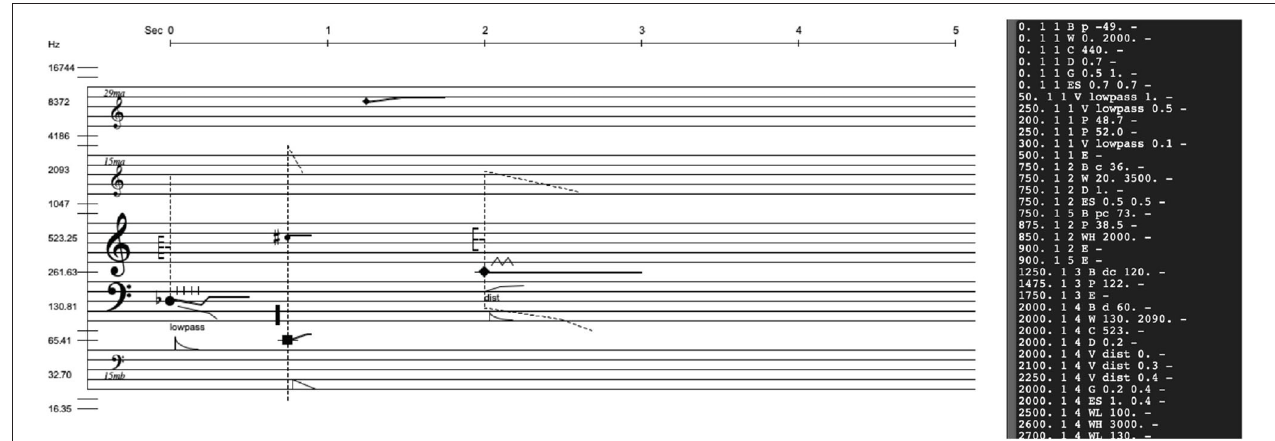
FIGURE 2 | Screen shot of the max implementation of the sound notation, in which the data in the black text block to the right has generated this score